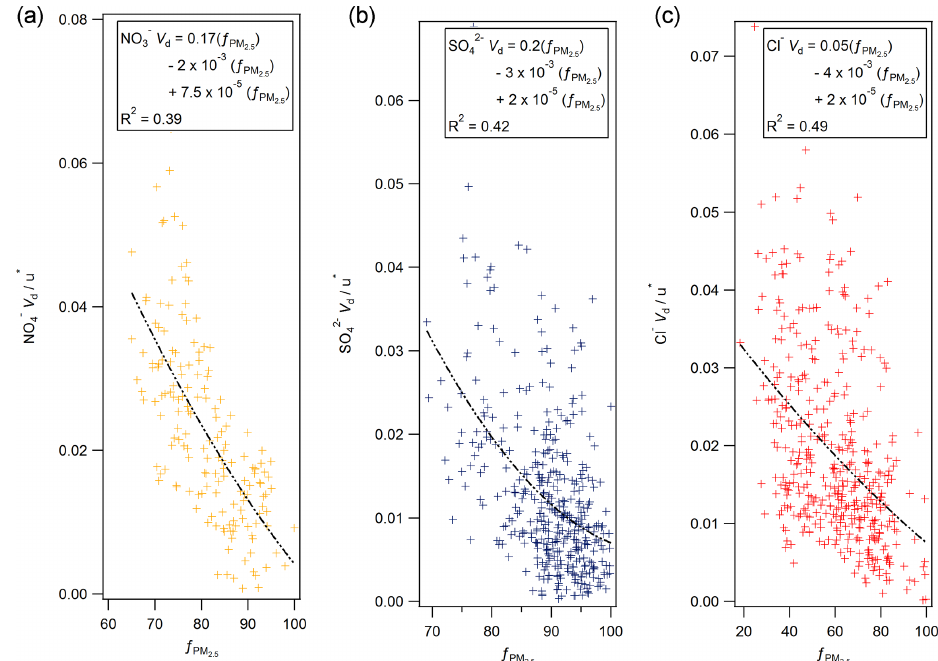
Figure 12. The normalised deposition velocity as a function of f PM from the MARGA measurements at Auchencorth